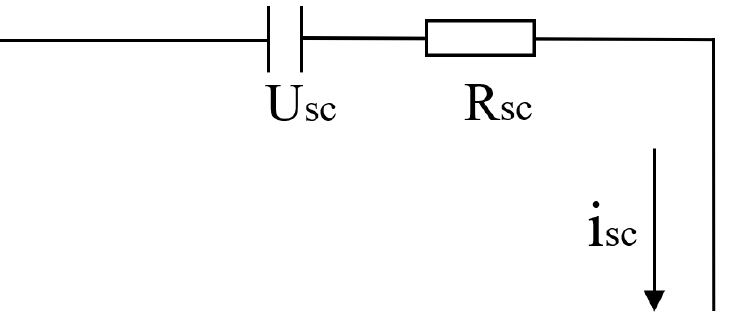
Figure 1. Supercapacitor RC Model.